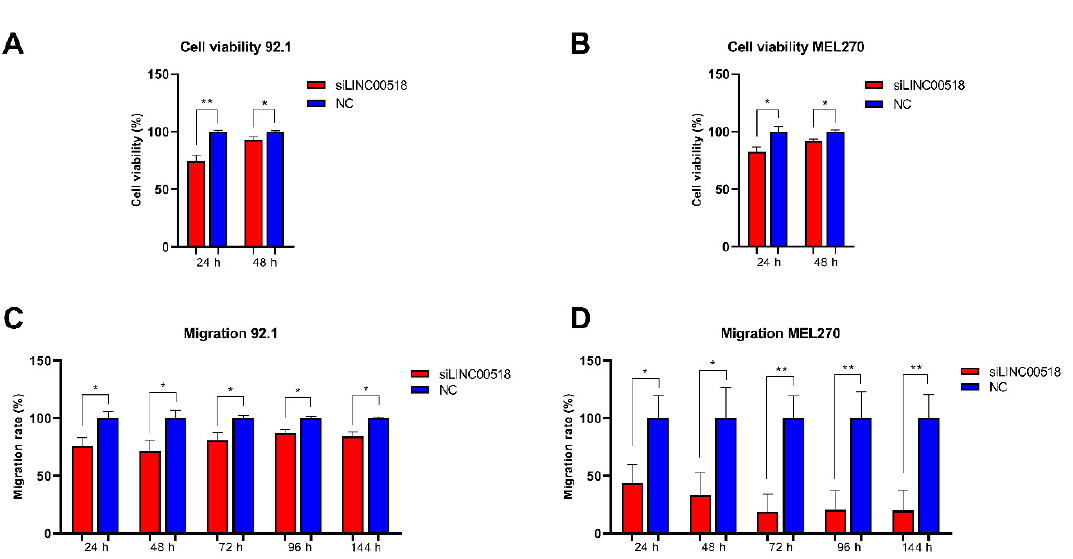
Figure 5. Evaluation of cell viability and migration after LINC00518 transient silencing. Cell viability was assessed through the MTT assay in ( A ) 92.1 and ( B ) MEL270. Migration was investigated by the Oris Cell Migration Assay in ( C ) 92.1 and ( D ) MEL270. Each experiment was performed in six in vitro replicates. *: p -value < 0.05; **: p -value < 0.005.